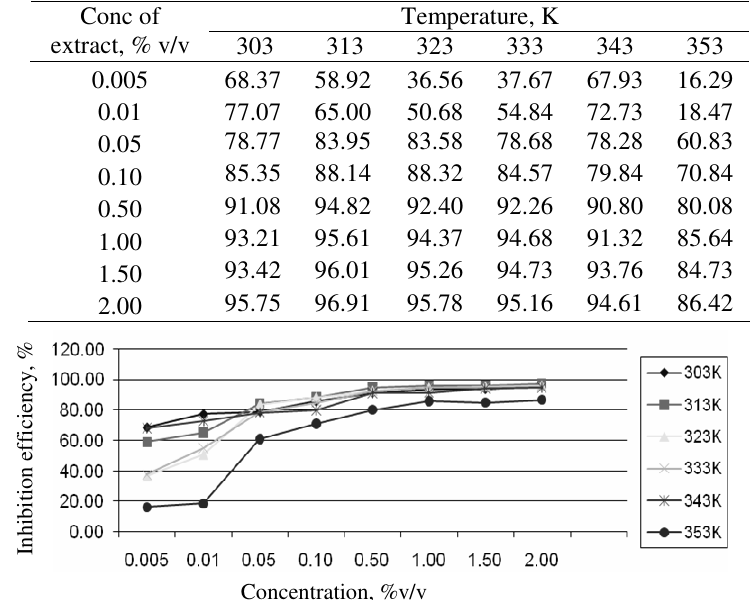
Figure 3. Effect of temperature on mild steel in 1 N HCl in presence and absence of MNP